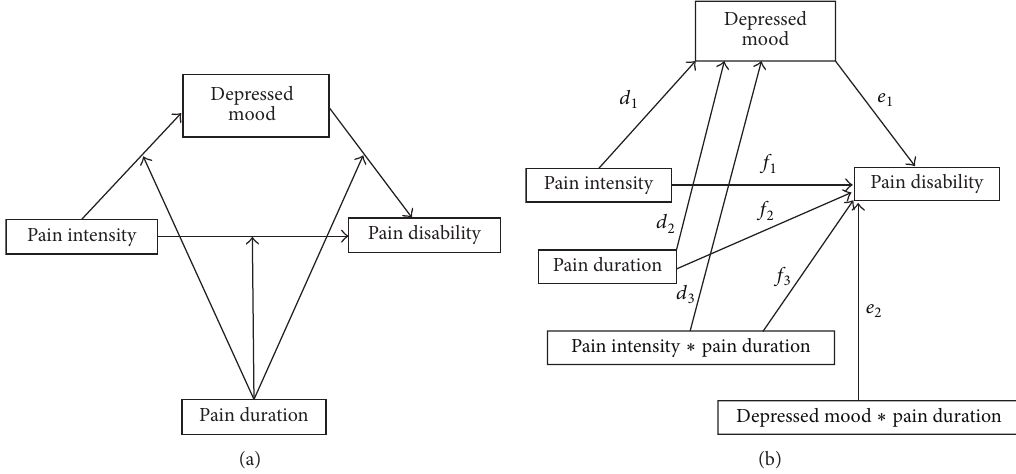
Figure 2: Conceptual (a) and statistical (b) diagrams of the moderated mediation model